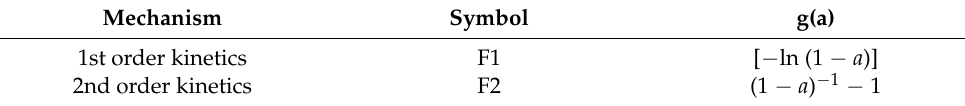
Mechanism Symbol 1st order